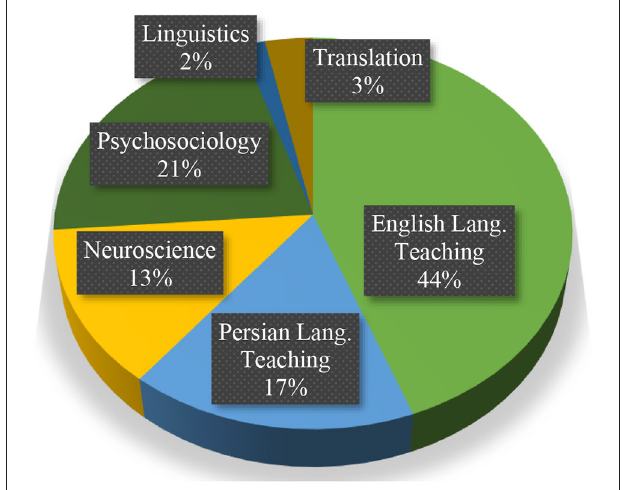
FIGURE 5 | Emotioncy studies in different disciplines.